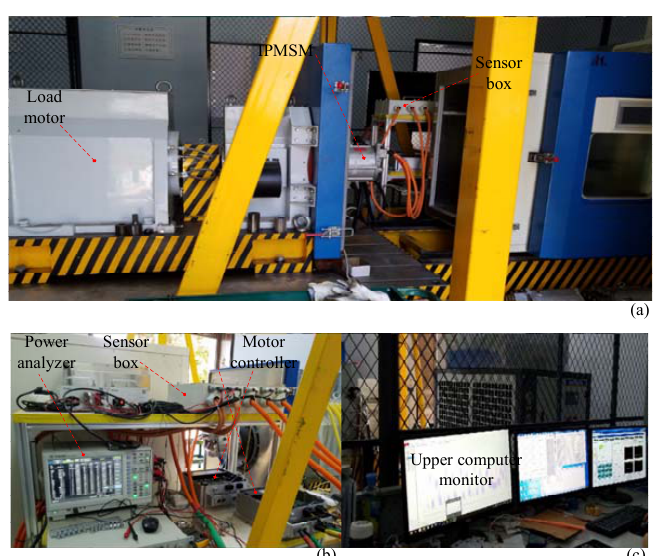
Figure 14. Dynamometer platform. ( a ) Dynamometer, ( b ) data acquisition system, ( c ) upper computer monitor.